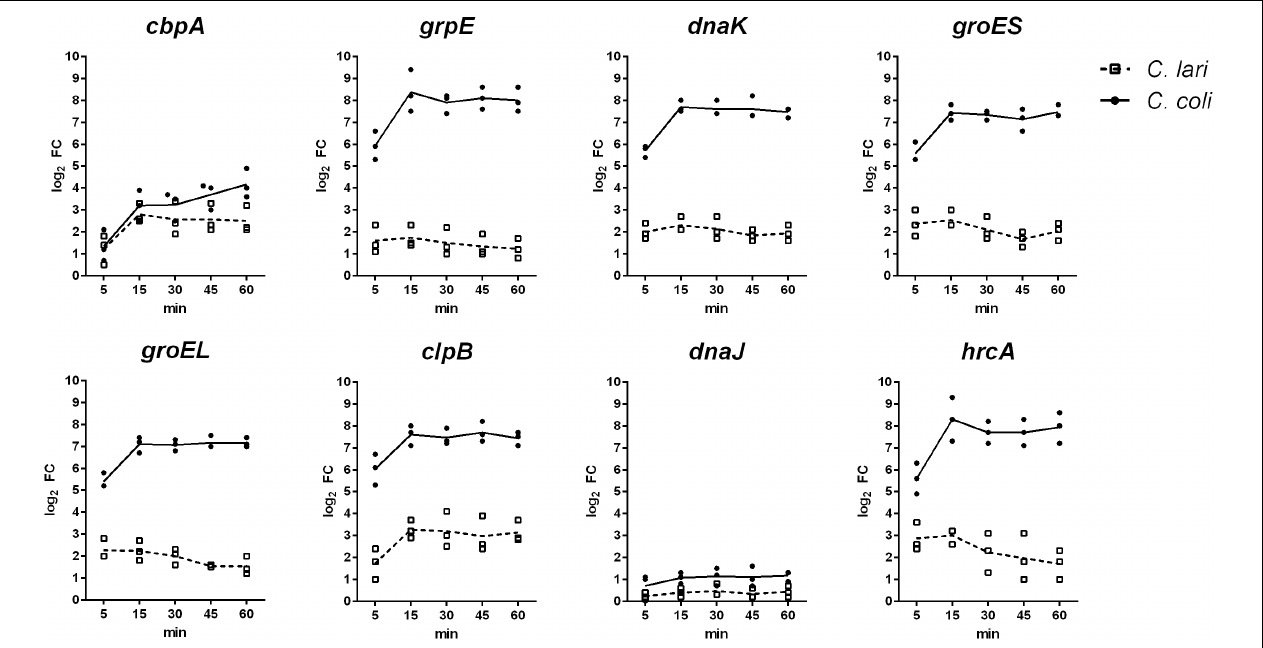
FIGURE 2 | Gene expression of known heat shock genes in C. coli RM2228 and C. lari RM2100 at 46 ◦ C compared to 37 ◦ C by qRT-PCR. Gene expression of selected heat shock genes was analyzed by qRT-PCR and normalized to the expression of rpoA and thiC . Fold changes of expression were calculated by the (cid:49)(cid:49) Cq method of CFX manager software. Log 2 fold changes for each biological replicate were shown and the means connected by the line.